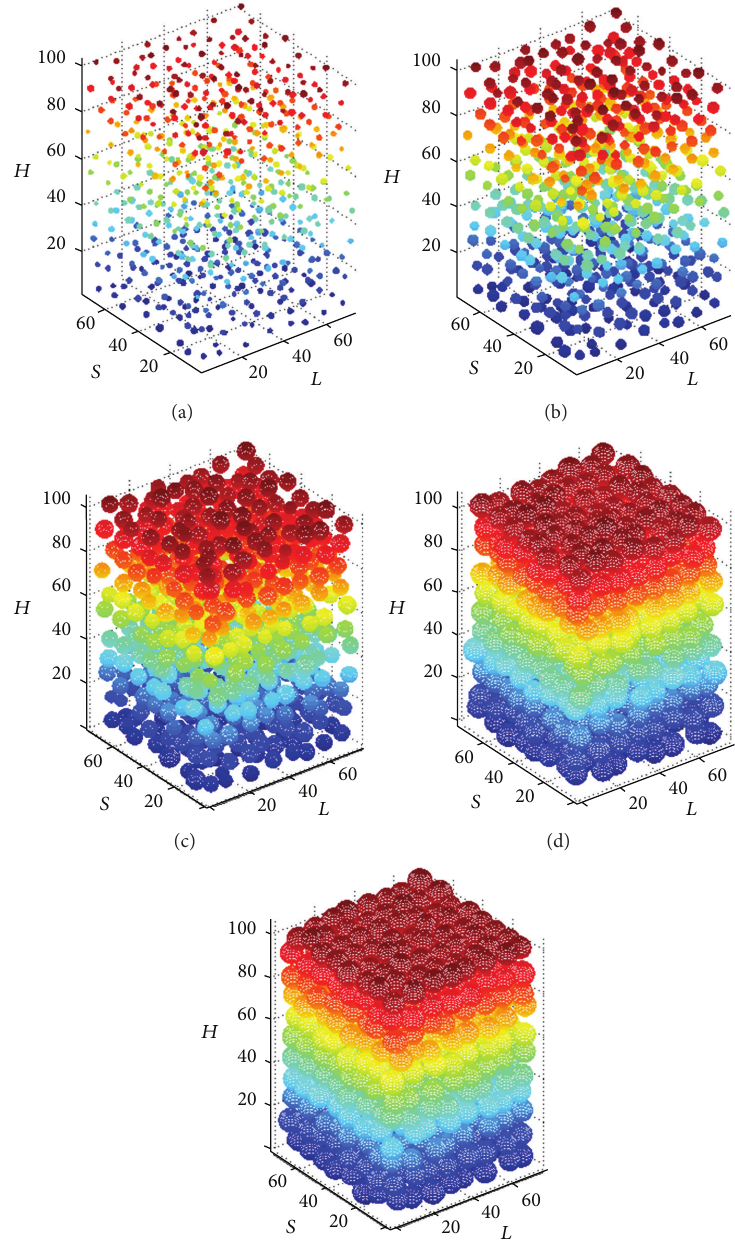
Figure 2: Modeling process with different cycle times (mm). (a) 𝑃 = 1 ; (b) 𝑃 = 20 ; (c) 𝑃 = 40 ; (d) 𝑃 = 50 ; and (e) 𝑃 = 55